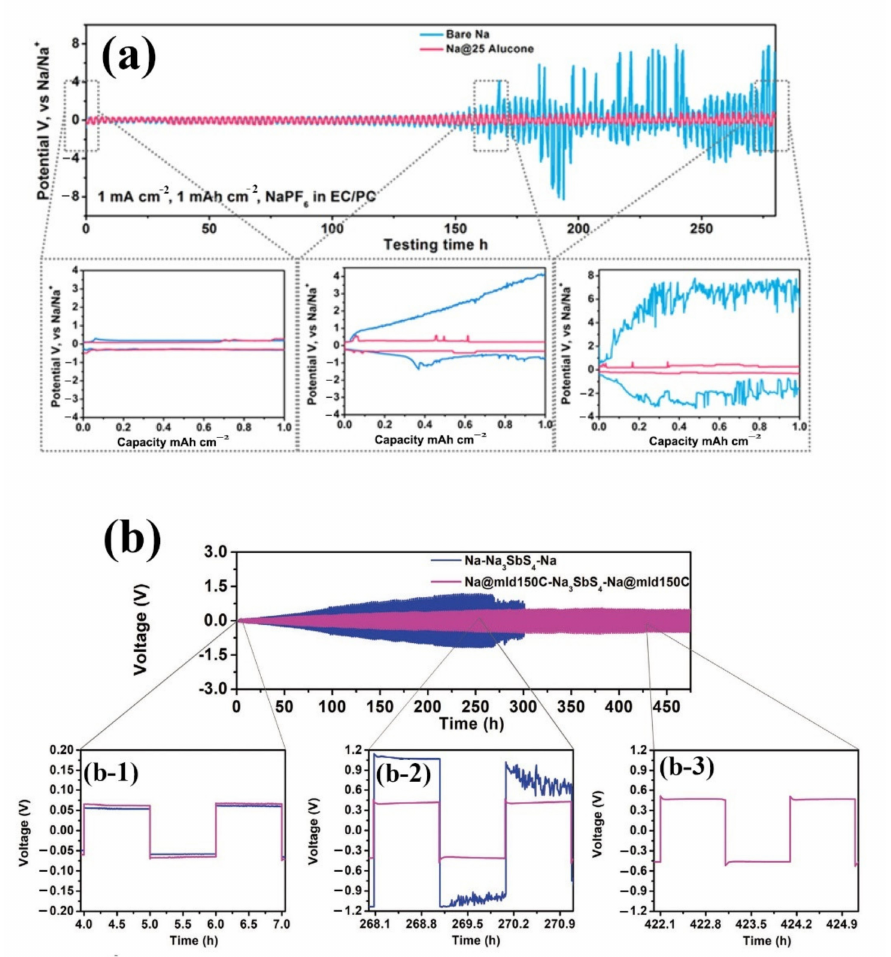
Figure 12. ( a ) Cycling stability of symmetric cells using bare Na and alucone-coated Na in carbonate electrolyte at 1 mA cm − 2 [112]. Reproduced with permission [112]. Copyright 2017, American Chemical Society. ( b ) Cycling stability of all-solid-state Na cells using bare Na and Na@mld150C [118]. Reproduced with permission [118]. Copyright 2020,